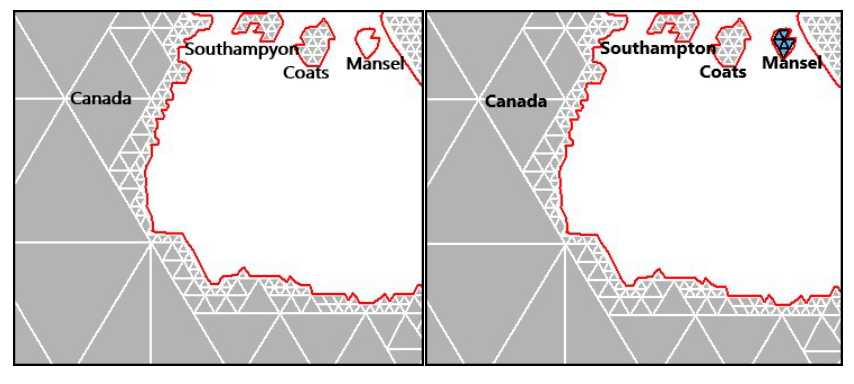
Figure 16. Three examples of topology distortion repair.